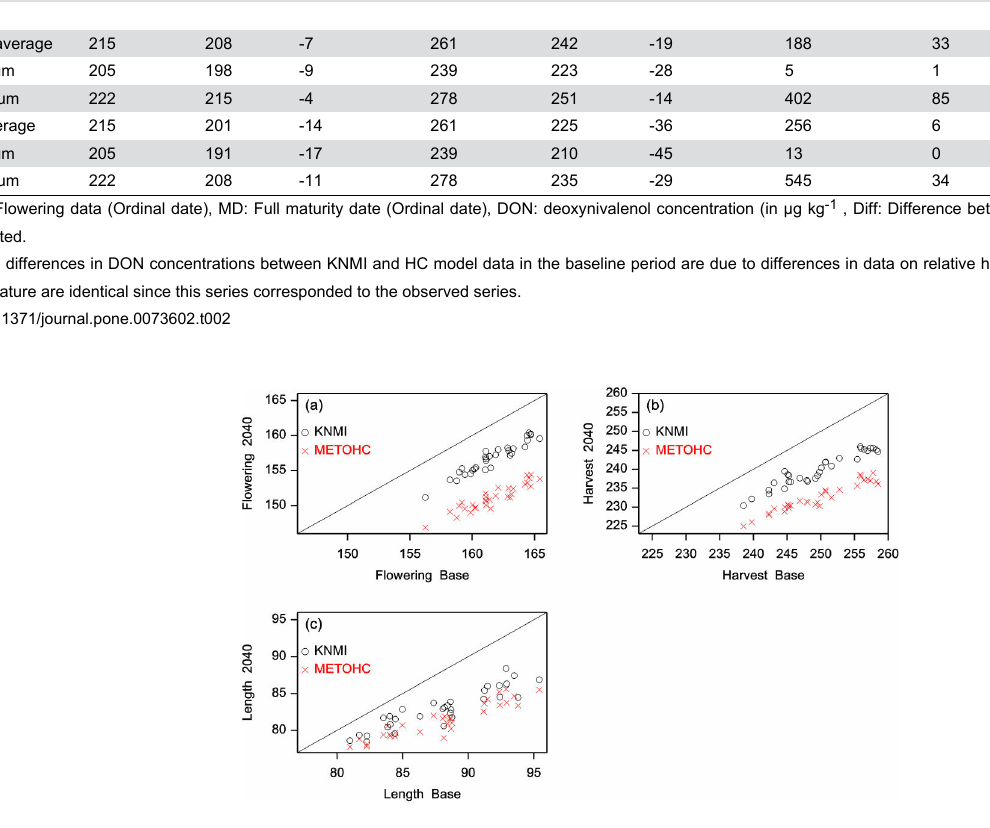
Figure 3. Estimated future flowering and full maturity dates of winter wheat. Estimated flowering (a) and full maturity dates (b) as well as difference between these two dates (length of grain filling period, c) as average of each grid (n=31) for winter wheat in the baseline period (1975-1994) and the future scenario period (2031-2050) using KNMI model data and HC climate model data. Dates are expressed as Julian